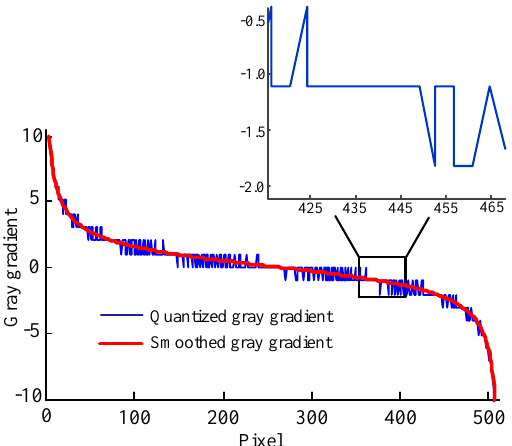
Figure 4. Gray gradient curve in the x -direction.